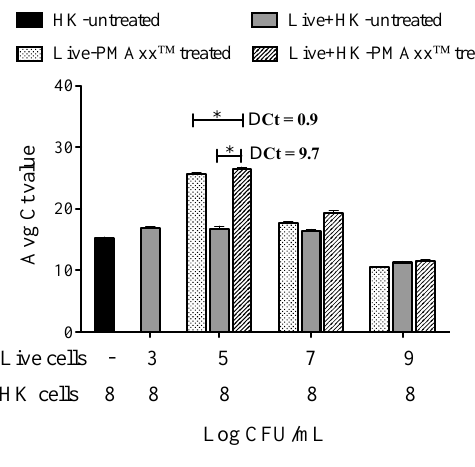
Figure 1. Effect of optimized PMAxx™ treatment on 10 8 CFU/mL HK cells spiked into live cell dilutions from 10 9 to 10 3 CFU/mL. The total reaction volume for the live and HK cell mixture was 200 µ L. Data were from 3 independent assays with 3 PCR replicates. HK-untreated and Live- PMAxx™ treated were used as treatment controls for Ct value comparisons of the cell mixtures. PCR results of 10 8 CFU/mL HK- PMAxx™ treated, 10 3 CFU/mL live- PMAxx™ treated, and 10 3 CFU/mL live + 10 8 CFU/mL HK- PMAxx™ treated were below the Ct cut-off value and were undetected and hence, not shown in the figure. ∆ Ct: difference in the cycle threshold. * denotes statistical significance ( p <